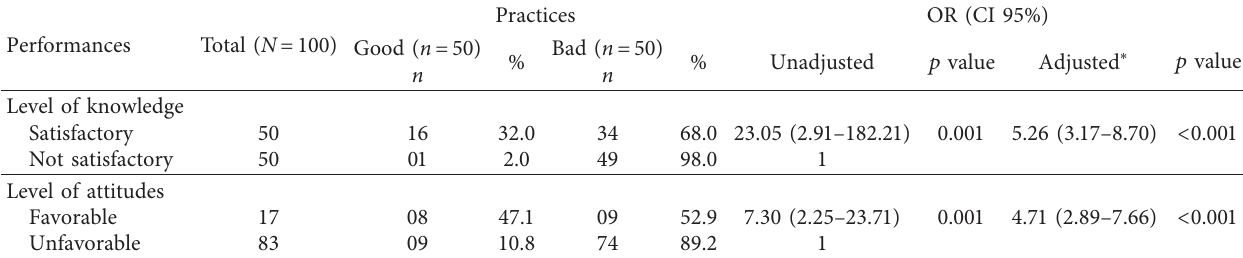
Table 5: Relation between practices and the levels of knowledge and attitudes of healthcare